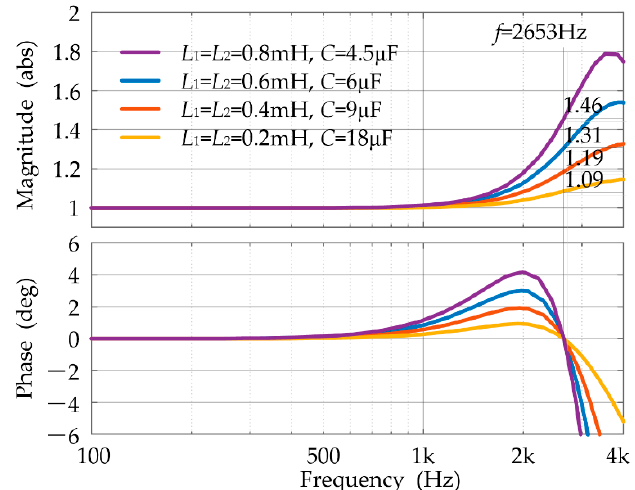
Figure 9. Bode plot of G (s) with different LCL parameters.